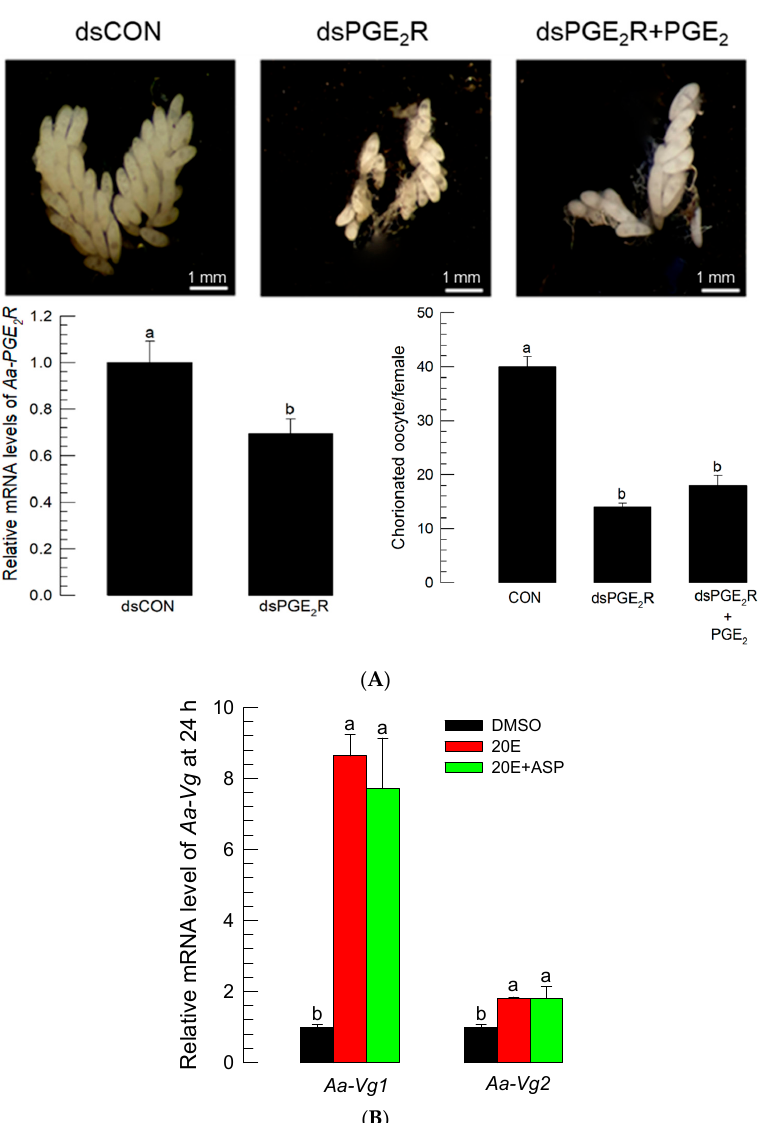
Figure 8. PGE 2 mediates oogenesis through its specific receptor (Aa-PGE 2 R), but it does not induce Vg production. ( A ) Influence of RNAi specific to Aa-PGE 2 R on choriogenesis. RNAi was performed by injecting 300 ng of gene-specific dsRNA (‘dsPGE 2 R’) or control dsRNA (‘dsCON’) into 5-day-old females at 10 min before blood-feeding (BF). Changes in mRNA levels were assessed by RT-qPCR at 72 h after injecting dsPGE 2 R or dsCON. To confirm the RNAi treatment, PGE 2 (100 ng per female) was injected and accompanied by dsRNA (300 ng/adult) treatment. At 72 h after BF, the total num- ber of chorionated oocytes was counted under a stereomicroscope. Each treatment used 10 females. ( B ) Effect of ASP (100 ng/adult) on expressions of two vitellogenin genes ( Aa-Vg1 and Aa-Vg2 ) in response to 20-hydroxyecdysone (20E, 50 ng/adult) injection. Treated females were not blood-fed. ‘ASP+20E’ represents the co-injection of two chemicals. All treatments were independently repli- cated three times. The Vg gene expression levels were measured by RT-qPCR at 24 h after the chem- ical treatments. The different letters above the standard error bars indicate significant differences among means at Type I error = 0.05 (LSD test). 3.7. No Effect of Aspirin on Vitellogenin (Vg) Expression Two Vg genes were predicted from Ae. albopictus genome: Aa-Vg1 and Aa-Vg2 (Figure S8A). Their expressions were highly inducible to BF, wherein the Aa-Vg1 transcript level was much higher than that of Aa-Vg2 (Figure S8B). The 20E injection significantly induced both Vg genes. However, ASP injection did not inhibit the up-regulation of the two Vg gene expressions, which were induced by 20E (Figure 8B).